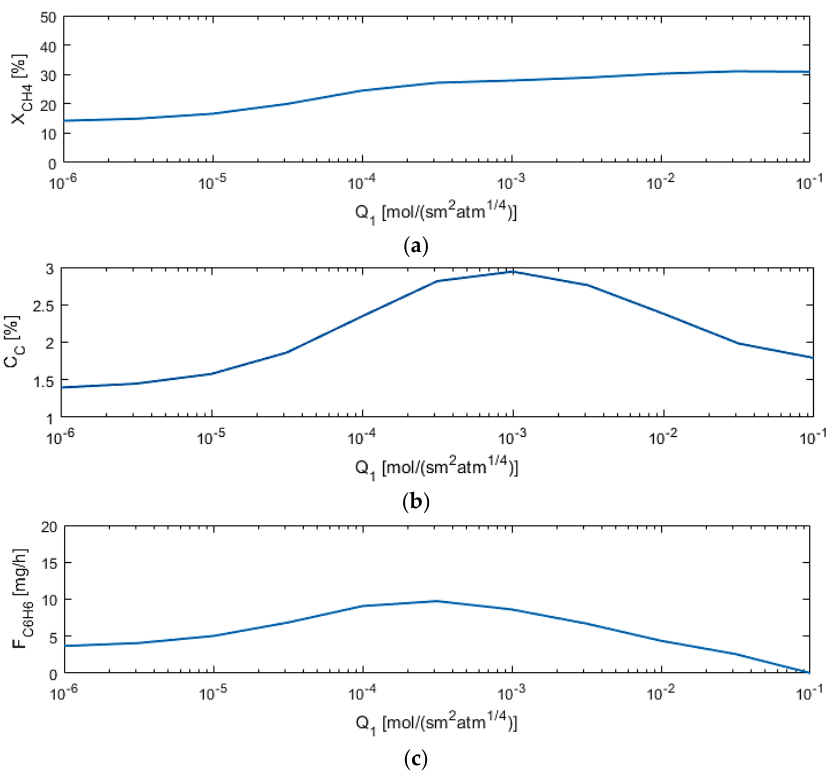
Figure 8. Sensitivity studies of Q 1 for model performance criteria: ( a ) X CH4 ; ( b ) C C ; ( c ) F C6H6 .